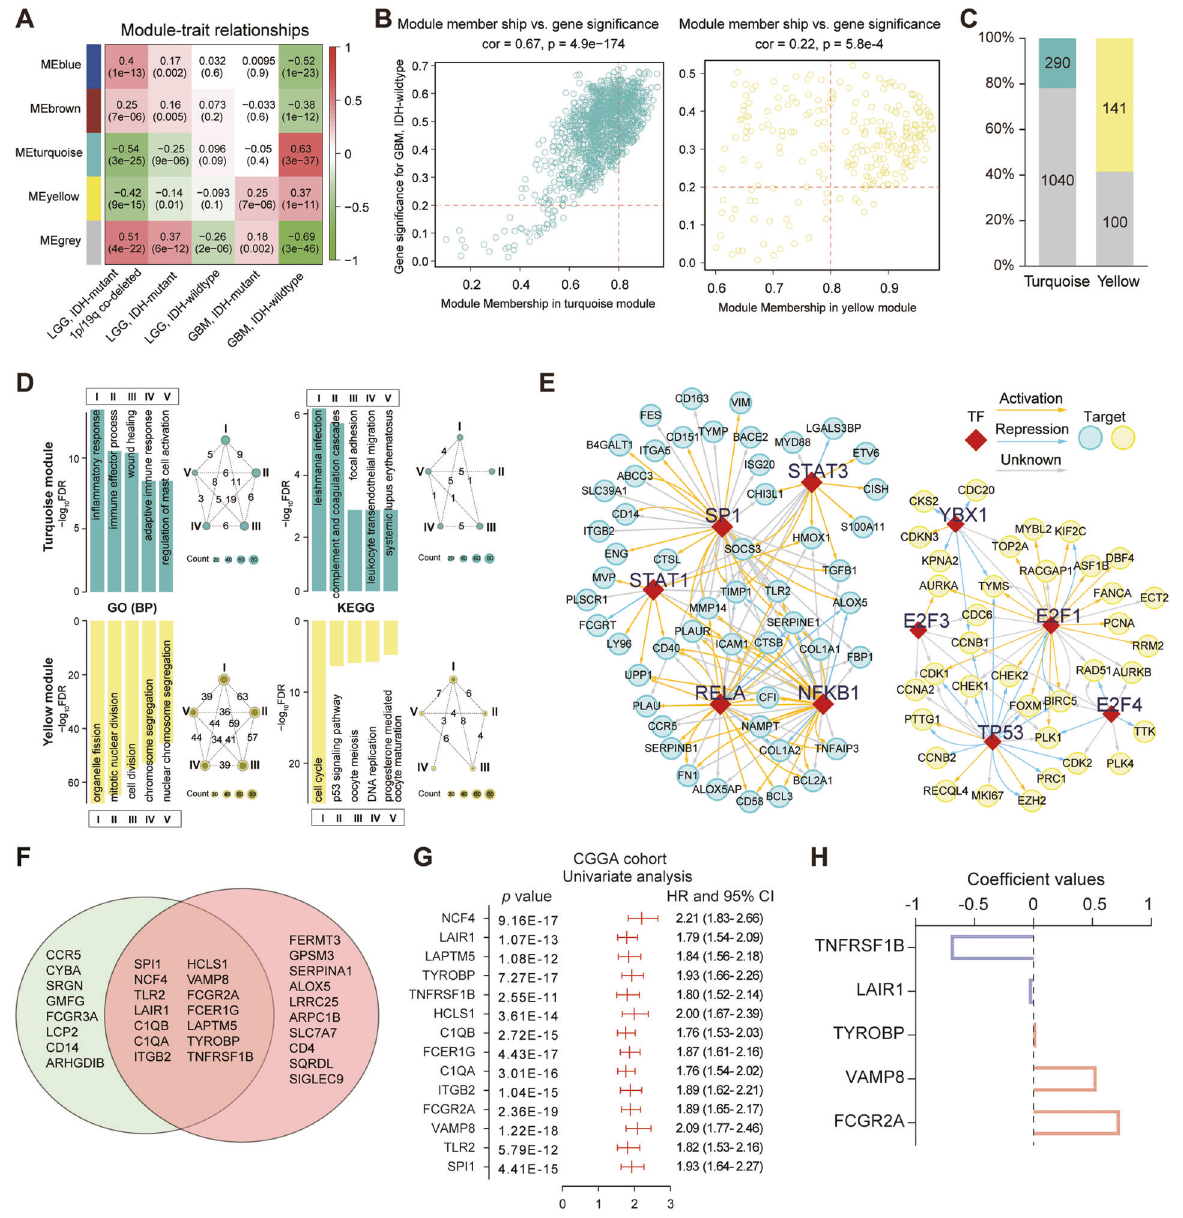
Fig. 1 Construction of a prognostic risk signature for OS by WGCNA and LASSO analysis. A Heatmap shows correlation between the gene modules and clinical traits. Each cell contains the corresponding correlation and p value. B The Module Membership (MM) versus Gene Signi fi cance (GS) scatterplot for GBM with IDH wildtype in turquoise or yellow module. Each dot represents a gene, and the red lines were set as a threshold for Module Membership > 0.8 and Gene Signi fi cance > 0.2. C The proportion of candidate hub genes in the turquoise and yellow modules. D GO (BP) and KEGG enrichment annotation of candidate hub genes in turquoise or yellow module. GO gene ontology, BP biological process. In the network diagram, the roman number residing in each circle represents a functional term; values on each line indicate number of overlap genes between terms. E Key regulated upstream transcription regulators (TFs) of candidate hub genes in module by TRRUST. F Hub genes were selected based on overlap between co-expression network and STRING analysis. G Univariate Cox regression results for the 14 genes in the CGGA dataset. H Coef fi cient values of the fi ve selected genes by